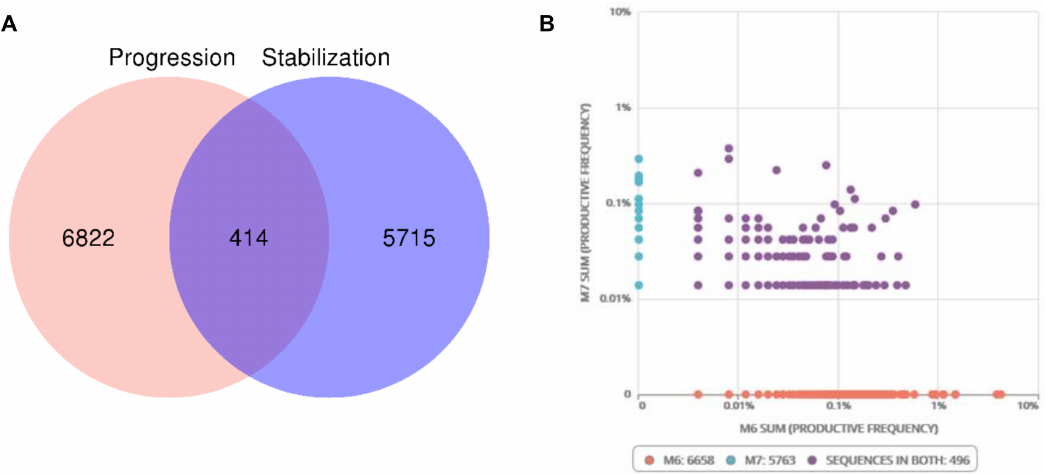
Figure 3. T-cell receptor (TCR) profile at both stages of the disease. ( A ) Total number of clonal rearrangements was higher during progression (M6) compared to stabilization (M7). Some of the rearrangements (414) were shared between both stages. ( B ) The abundance of rearrangements was higher during progression. Of these total number of rearrangements, 496 were present at both stages of the